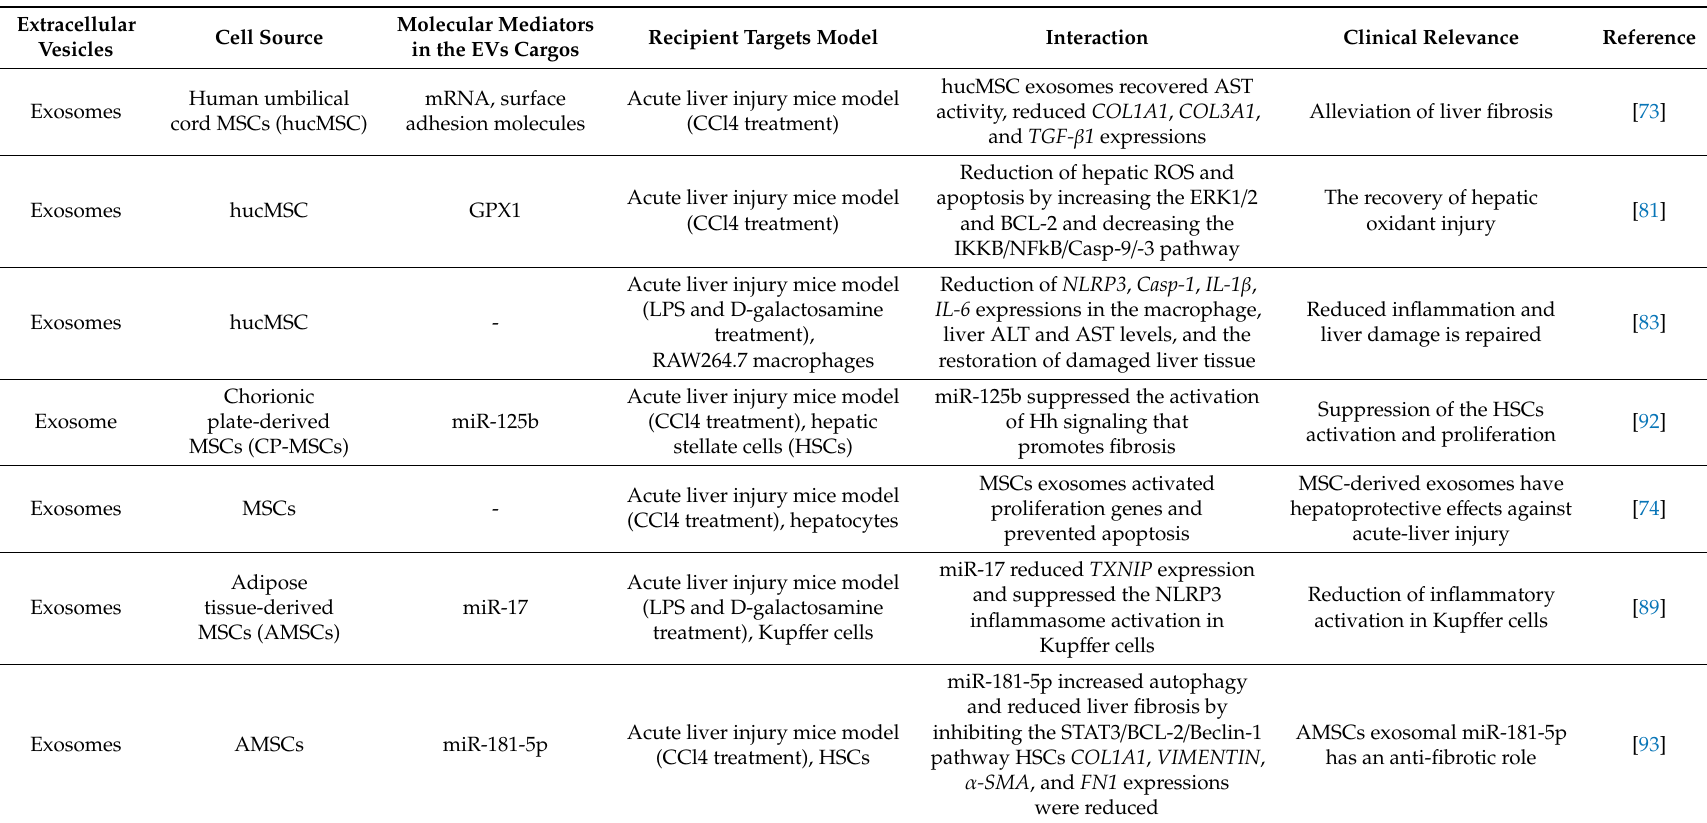
Table 2. Comparisons of extracellular vesicles (EVs) treatment from various mesenchymal stem cells and their clinical relevance to liver injury and disease.